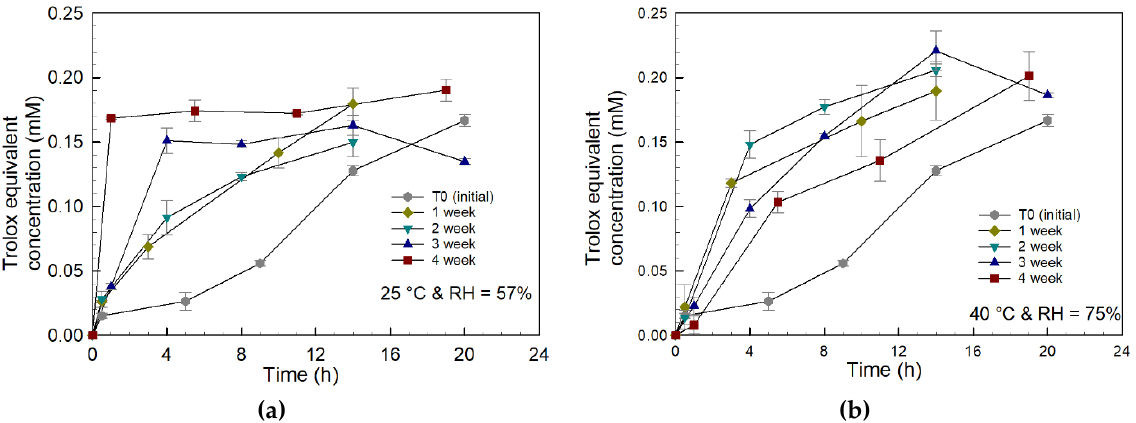
Figure 11. Antioxidant capacity of tablet dissolution supernatants measured for all storage times at standard conditions using Trolox equivalent antioxidant capacity (TEAC) in-vitro antioxidant measurement assay. ( a ) Standard conditions of 25 °C and RH = 57%; ( b ) accelerated conditions of 40 °C and RH = 75%.